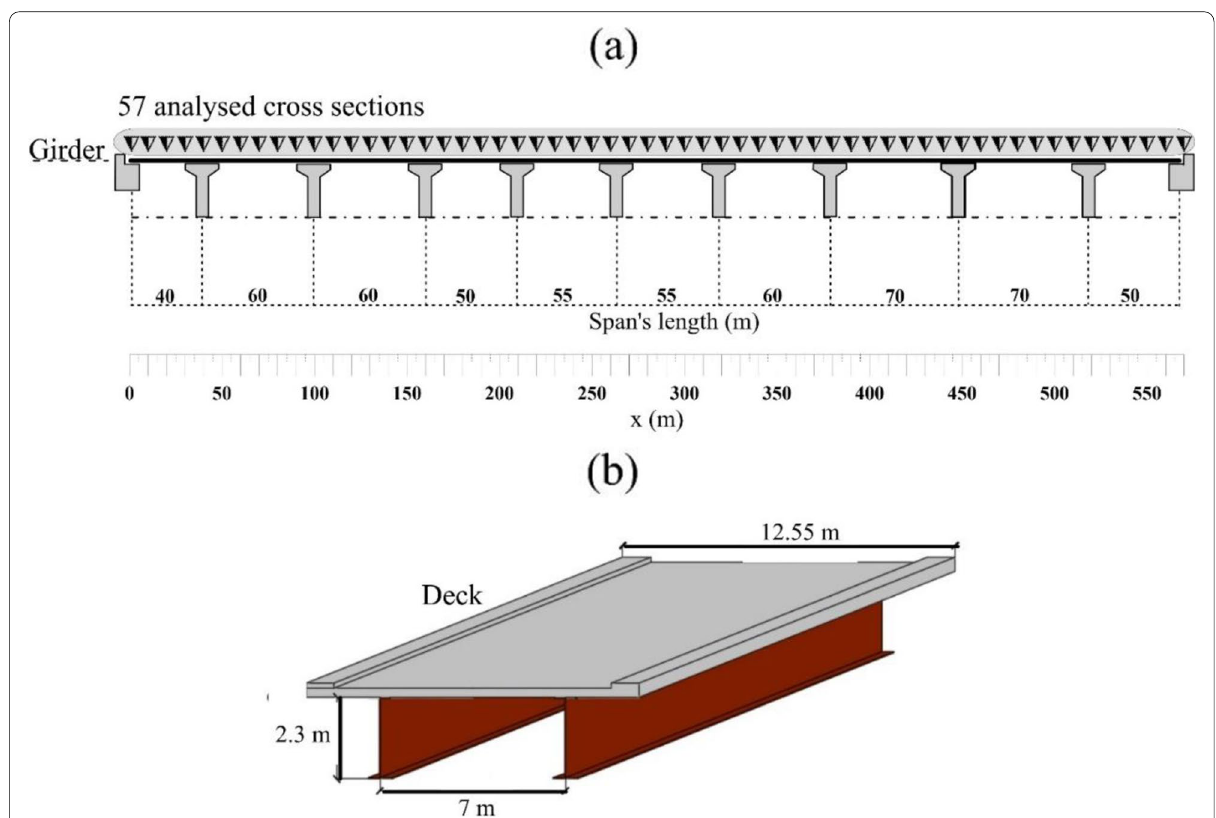
Fig. 2 Schematic representation of the bridge: longitudinal cross section with the indication of the analysed cross-sections a ) and 3D view of a portion of the deck b )